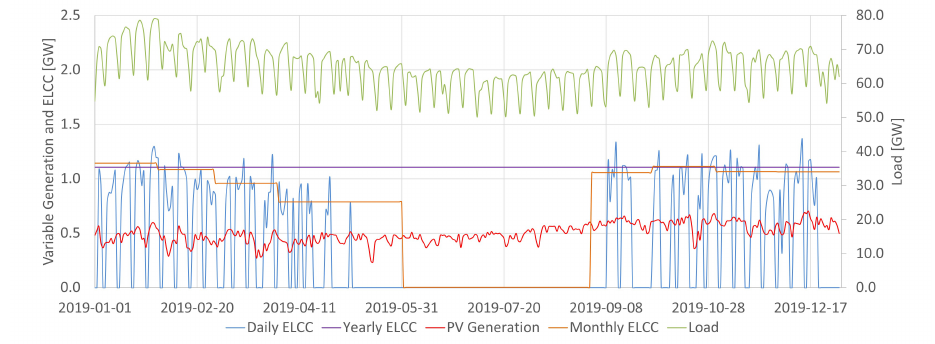
Figure 9. Daily, monthly and yearly ELCC for PV power in 2019 for the